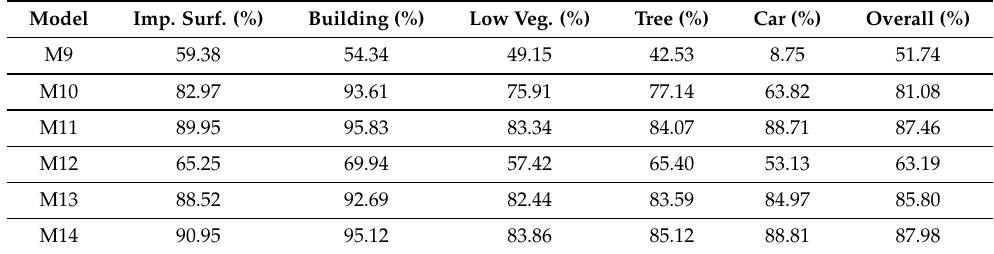
Table 6. Test scores obtained using full-dataset for single-stream segmentation models. All quality measures except for overall accuracy are F1 scores in [%]. Model Imp. Surf. (%) Building (%) Low Veg. (%) Tree